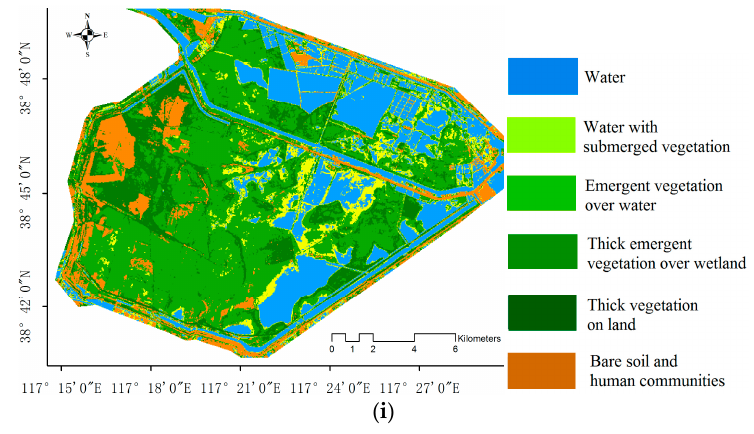
Figure 7. The classification results of the long-term series of Landsat satellite datasets from 1976 to 2015 based on the IT2FCM* algorithm. ( a – i ) correspond to 1976, 1980, 1985, 1990, 1995, 2000, 2005, 2010, and 2015 classification results.